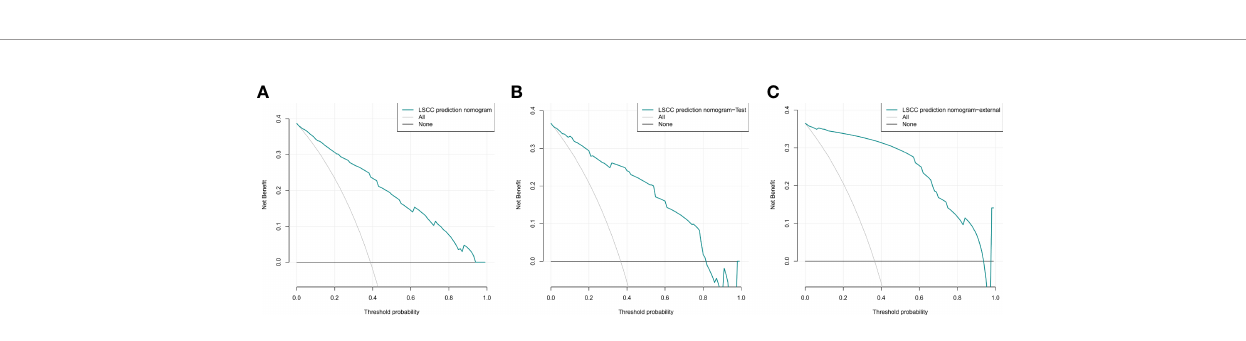
FIGURE 8 | Decision curve analysis of the nomogram of the training cohort (A) , internal test cohort (B) , and, external test cohort (C)